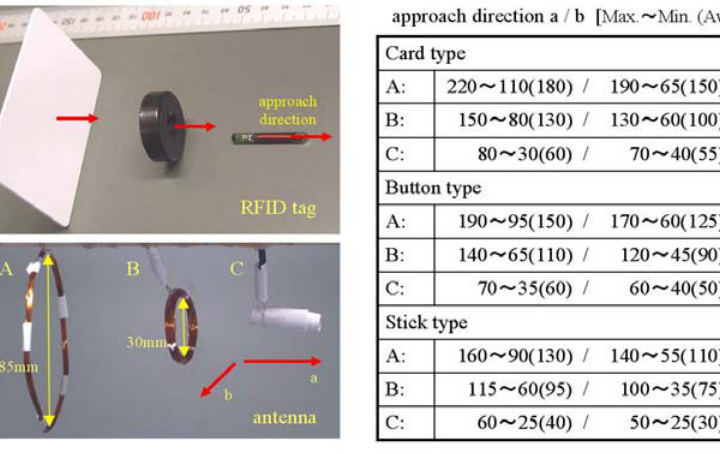
Figure 5. Experimental materials and results of RFID accessible